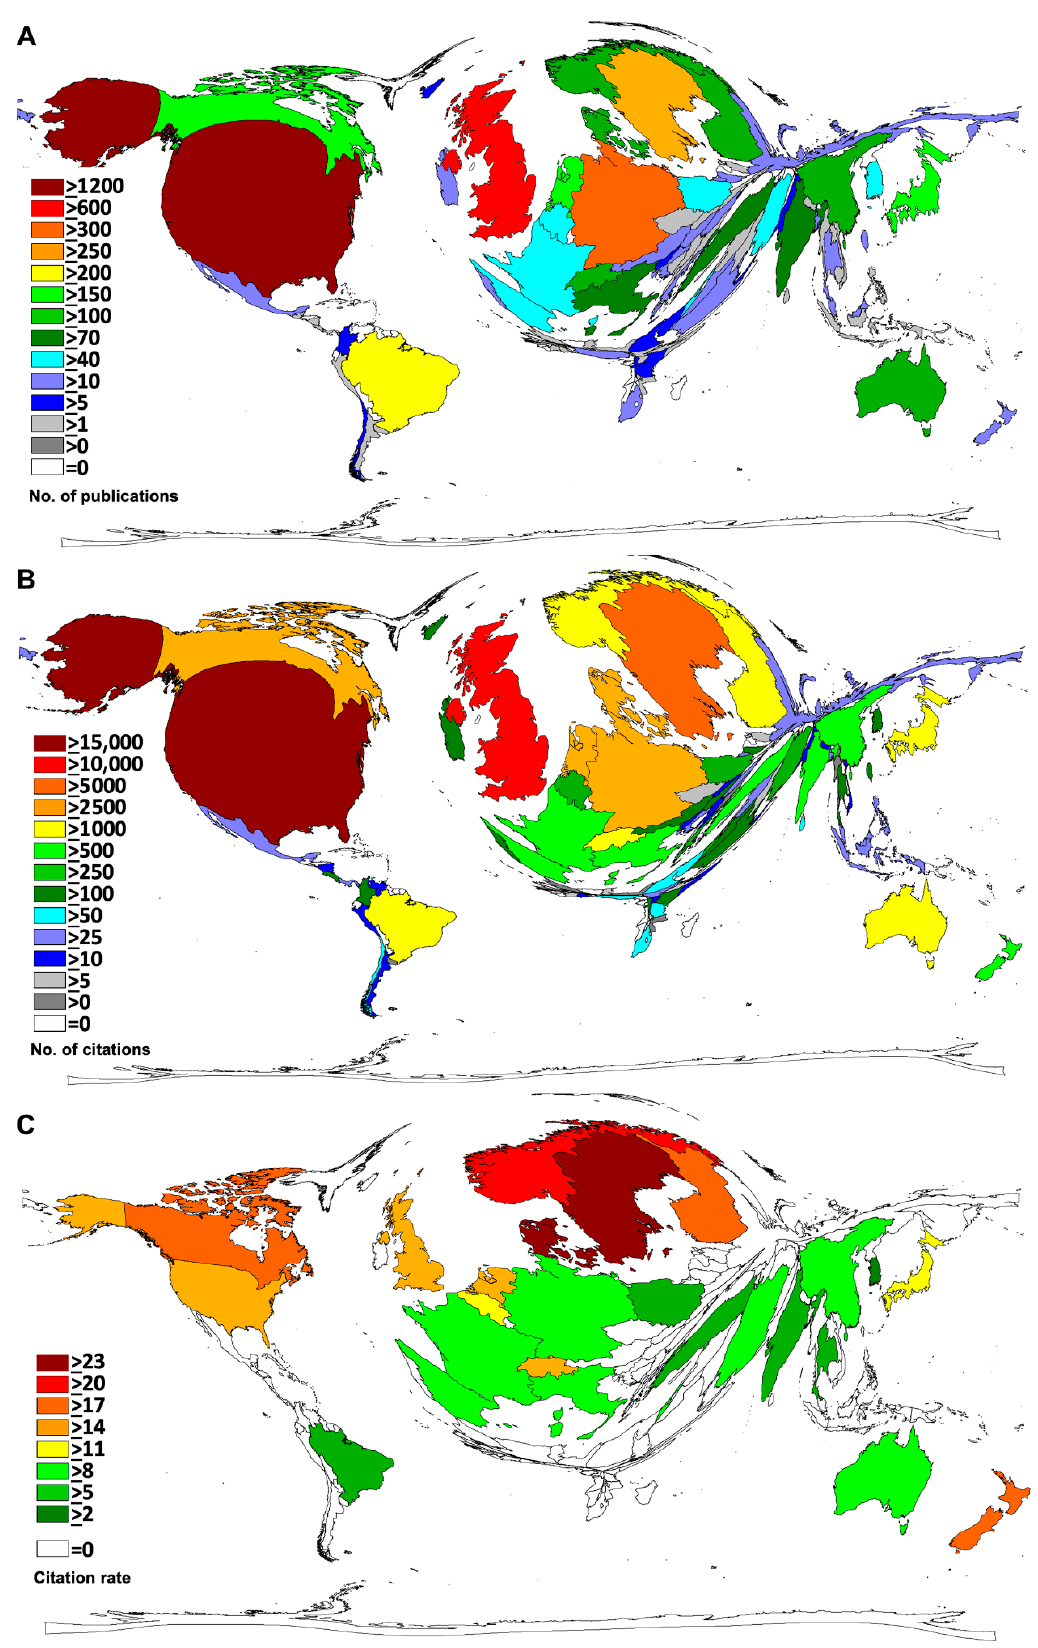
Figure 2. Countries’ performances on oral hygiene. ( A ) Number of articles. ( B ) Number of citations. ( C ) Citation rate (threshold > 30 articles).